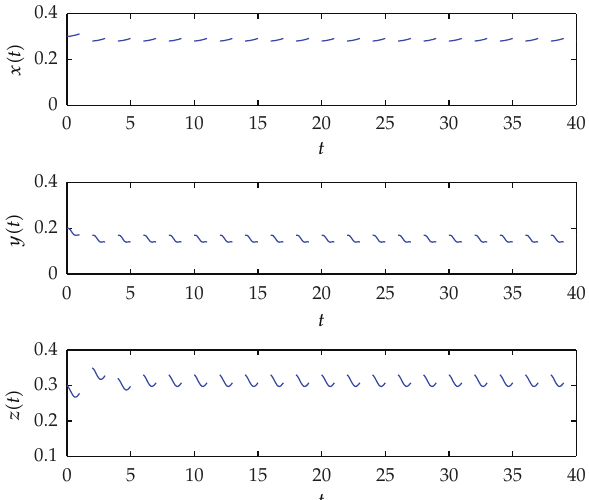
(cid:30) ∞ (cid:4) 2 k, 2 k (cid:10) 1 (cid:5) , m (cid:9) 0 . 6. Dynamics behavior of system (cid:6) 4.1 (cid:7) with initial condition x (cid:6) 0 (cid:7) (cid:9) 0 . 3, Figure 3: T (cid:9) k (cid:9) 0 y (cid:6) 0 (cid:7) (cid:9) 0 . 2, z (cid:6) 0 (cid:7) (cid:9) 0 . 3.